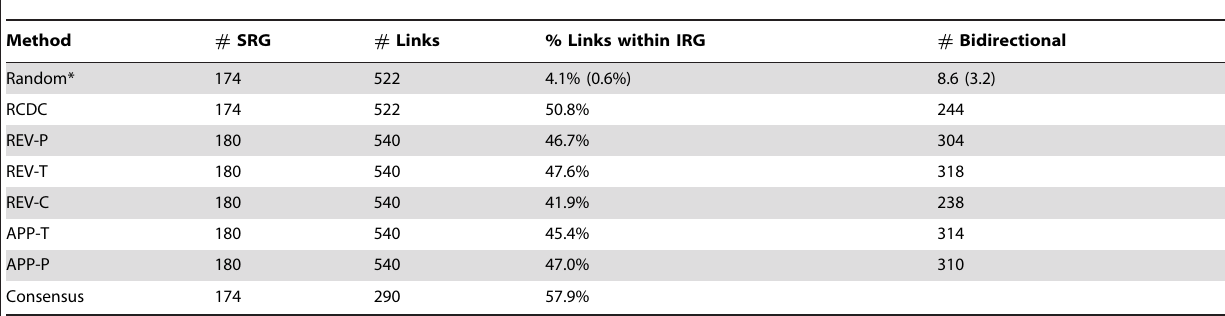
Table 1. Comparison of within-IRG links for each study section